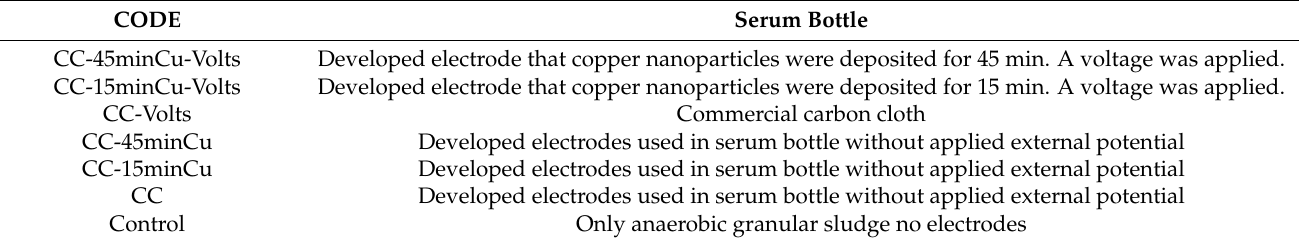
Table 1. Parameters used in each serum bottle.